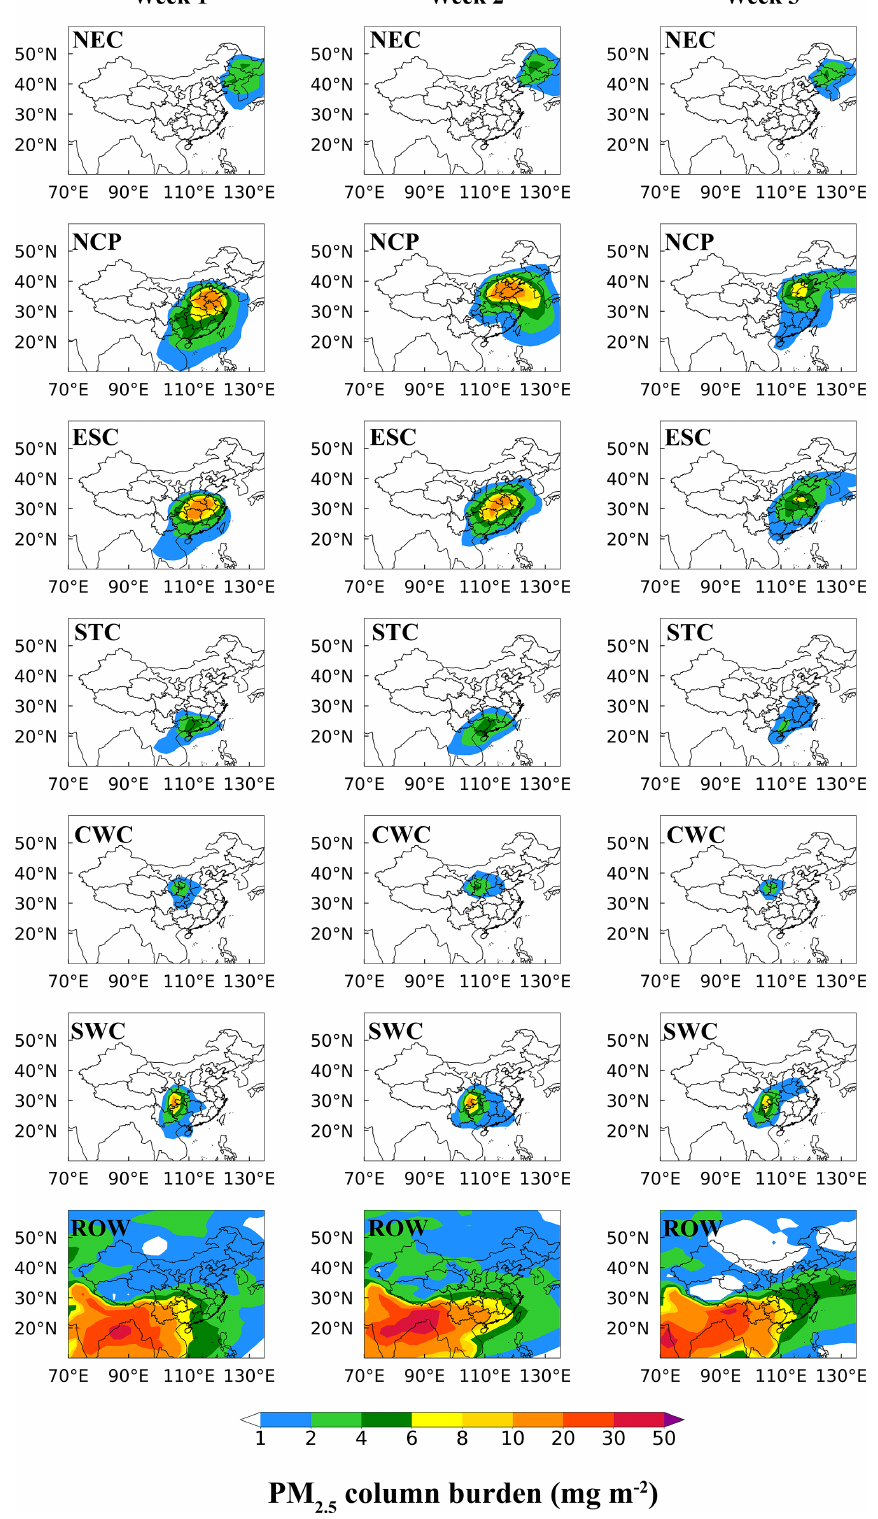
Figure 3. Spatial distribution of PM 2 . 5 column burden (mgm − 2 ) originating from the six major source regions in China (NEC, NCP, ESC, STC, CWC and SWC) and sources outside China (ROW) during the three time